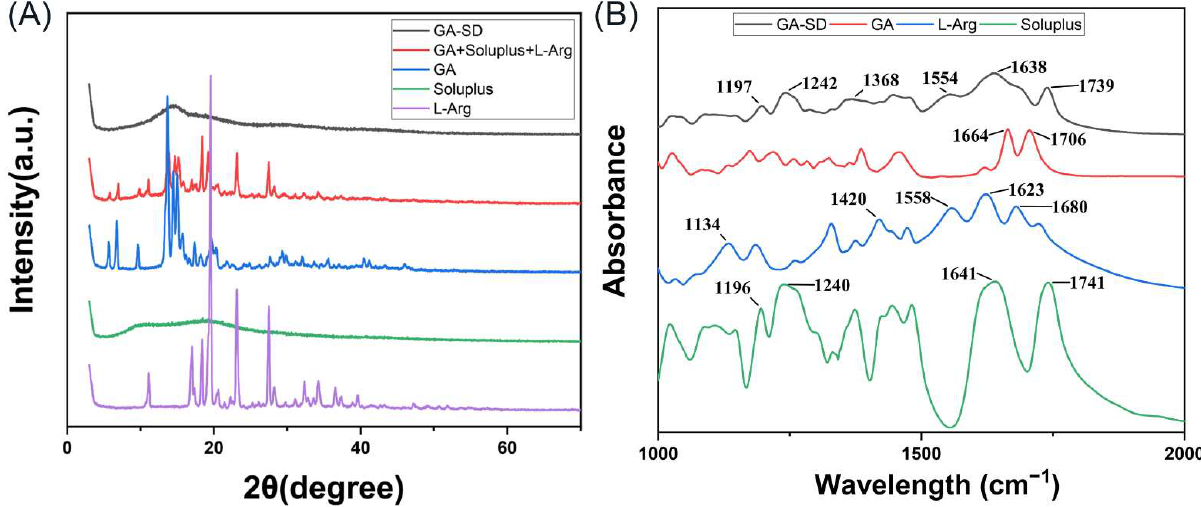
Figure 3. Structural analysis of solid dispersions. ( A ) XRD analysis of the GA-SD solid dispersion. ( B ) FT-IR spectra with the major characteristic peaks.